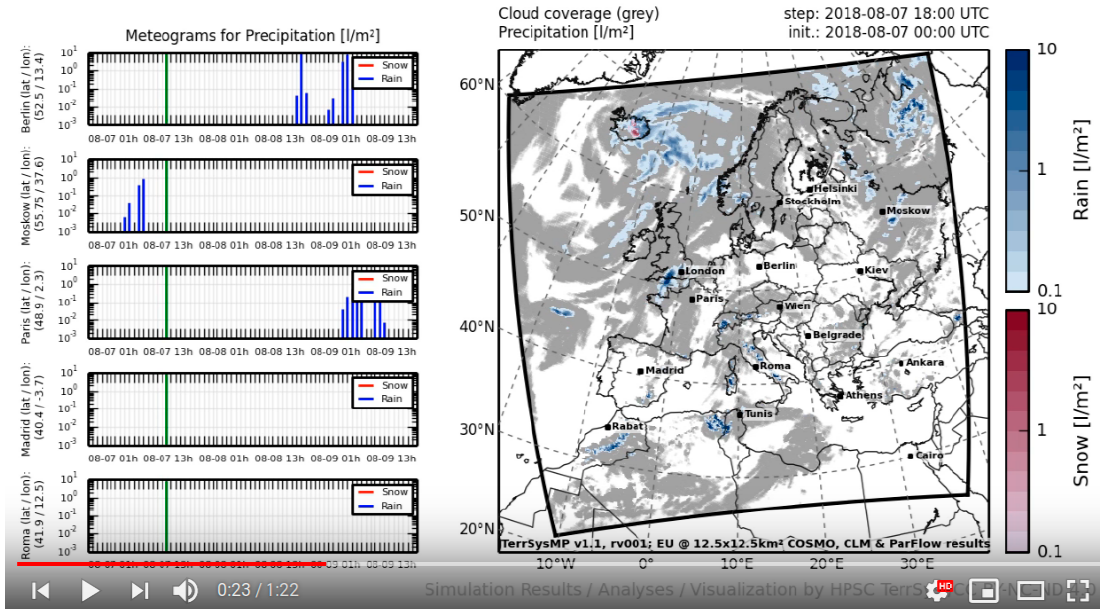
Figure 6. Monitoring output of TSMP (CORDEX EUR-11 domain) for precipitation (l·m − 2 or mm) in logarithmic scale on 7 August 2018. On the left from top to bottom, the meteograms depict precipitation rates (snow and rain) (l·m − 2 or mm) for the European capitals Berlin, Moscow, Paris, Madrid and Rome.